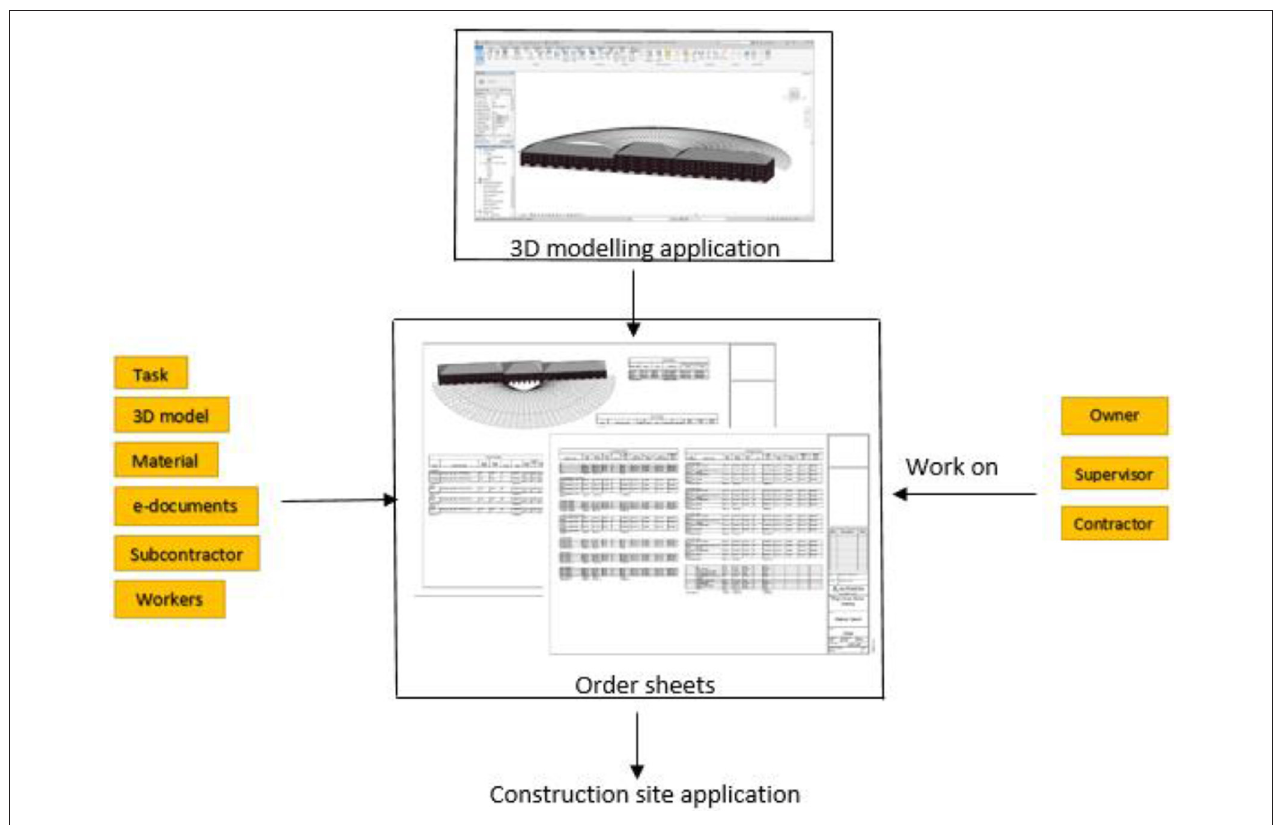
FIGURE 2 | The order sheet method for construction process control.